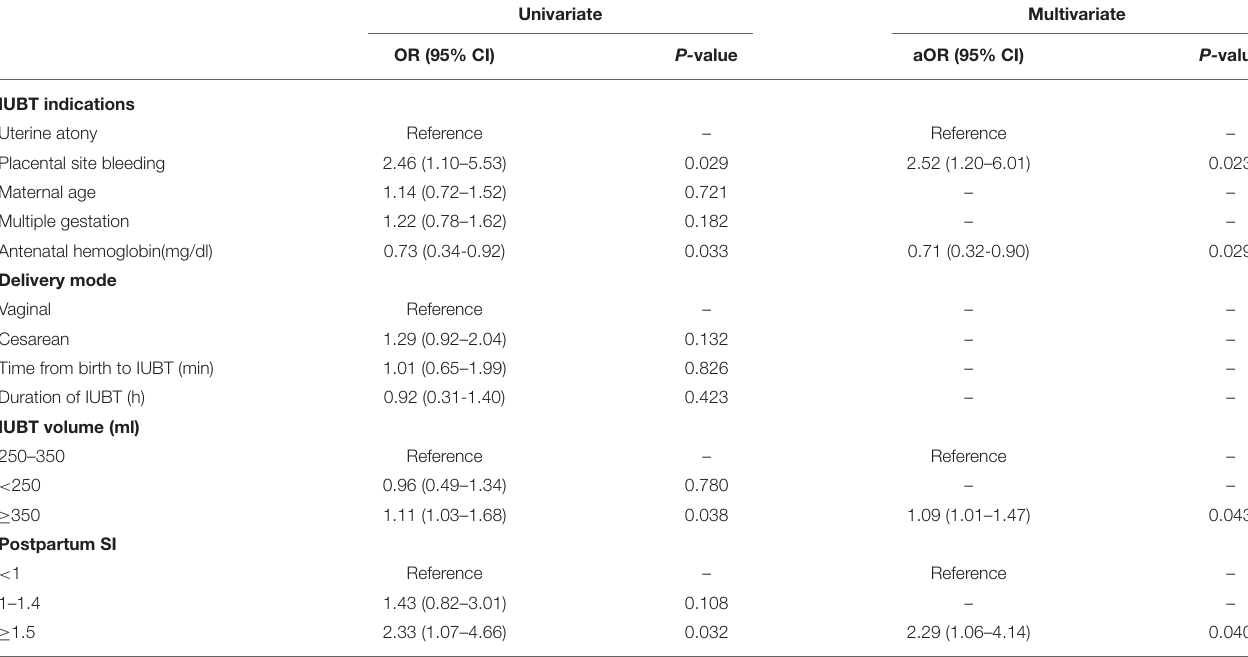
TABLE 5 | Risk factors for the prevalence of UAE or